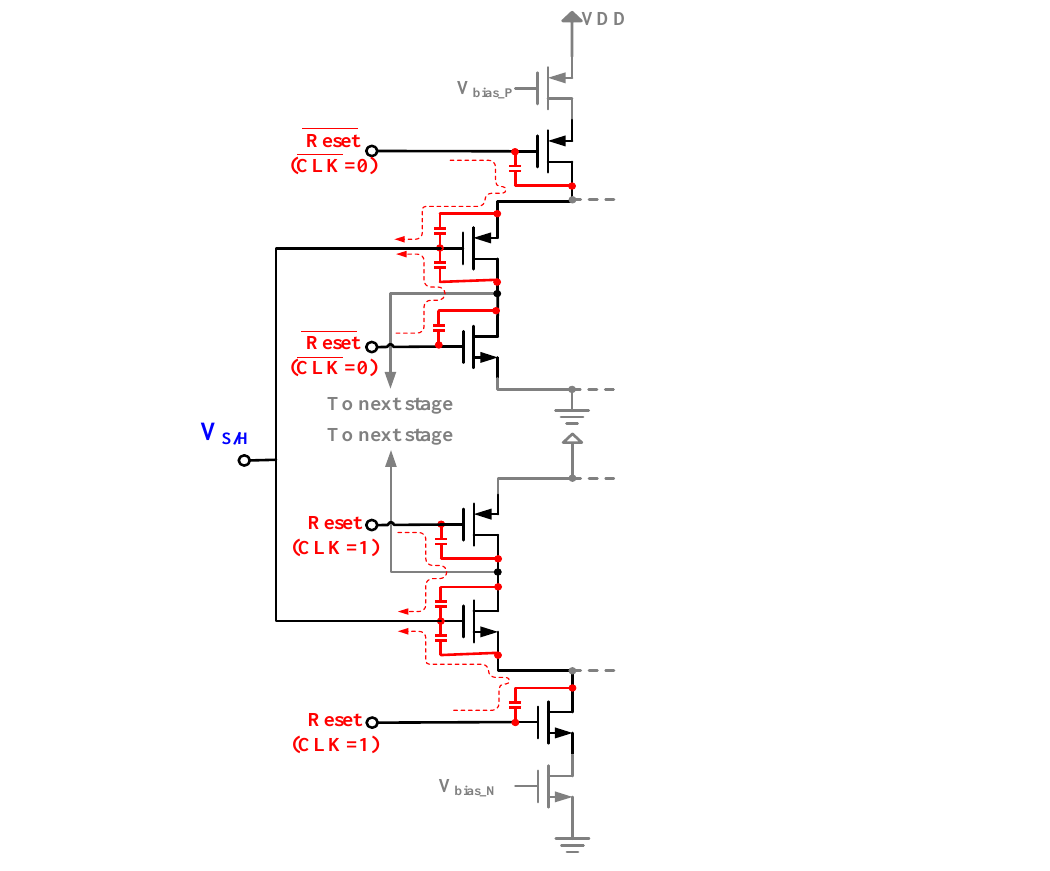
Figure 20. Clock feedthrough paths from N-type and P-type input stages at reset mode (CLK = 1 at N-type input stage).